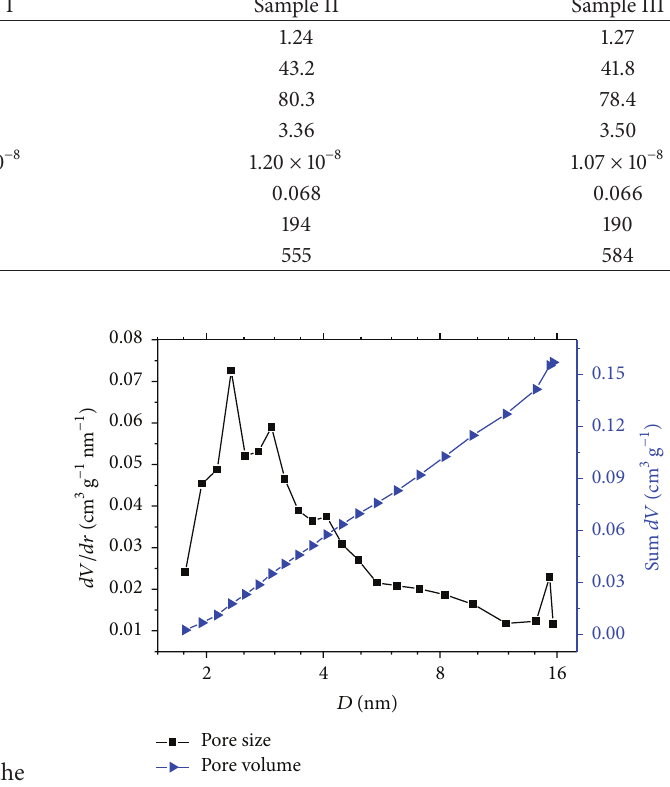
Figure 2: The curve of pore-volume and pore size of original sewage